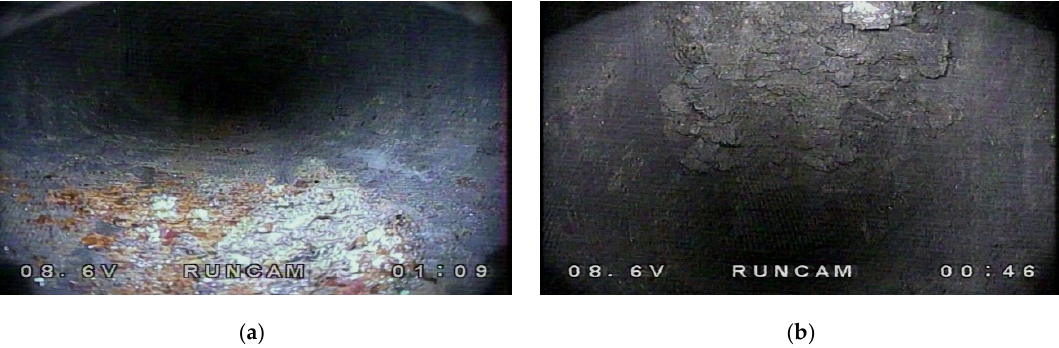
Figure 14. The experimental setup to evaluate the robot’s capability to pass ( a ) through a curved up elbow, ( b ) through a curved down elbow, and ( c ) by attaching to the ceiling.